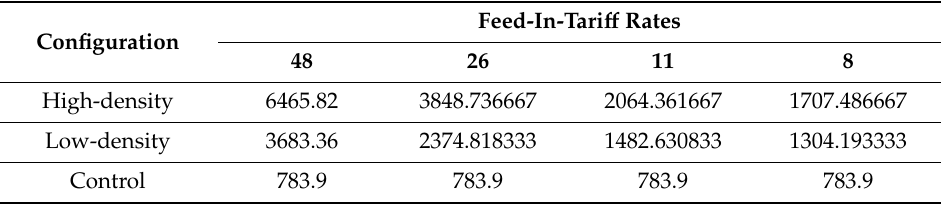
Table 9. Annual total revenue per square meter with di ff erent feed-in-tari ff